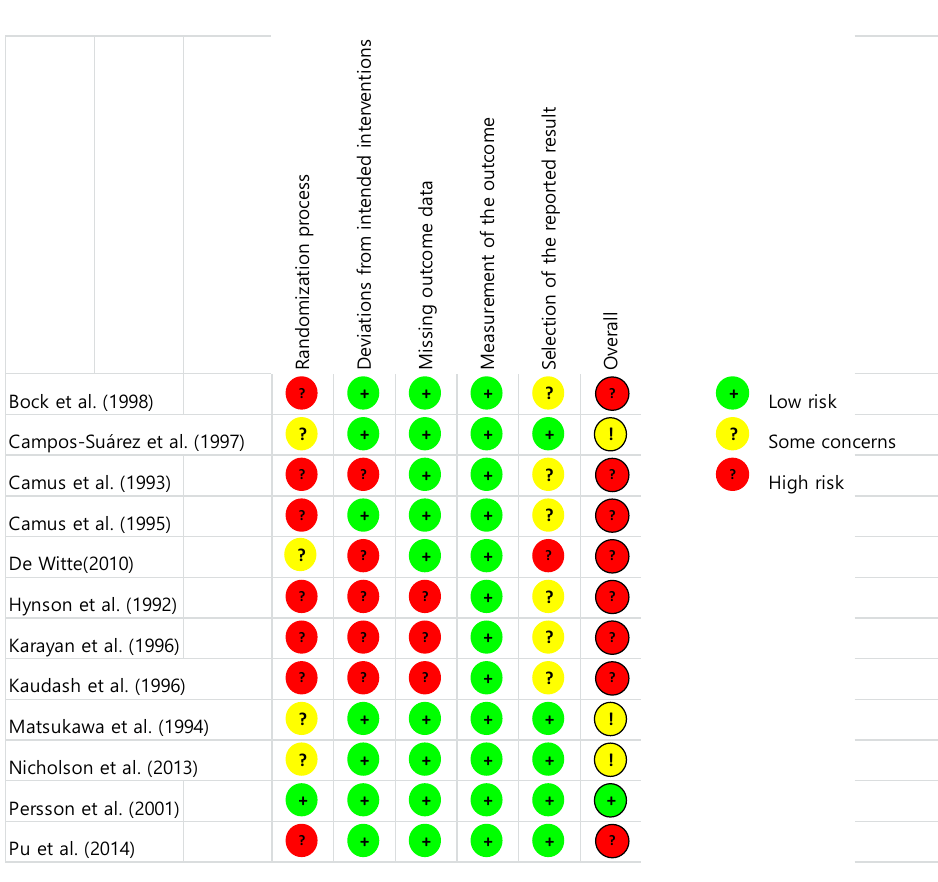
Figure 2. Risk of bias result.